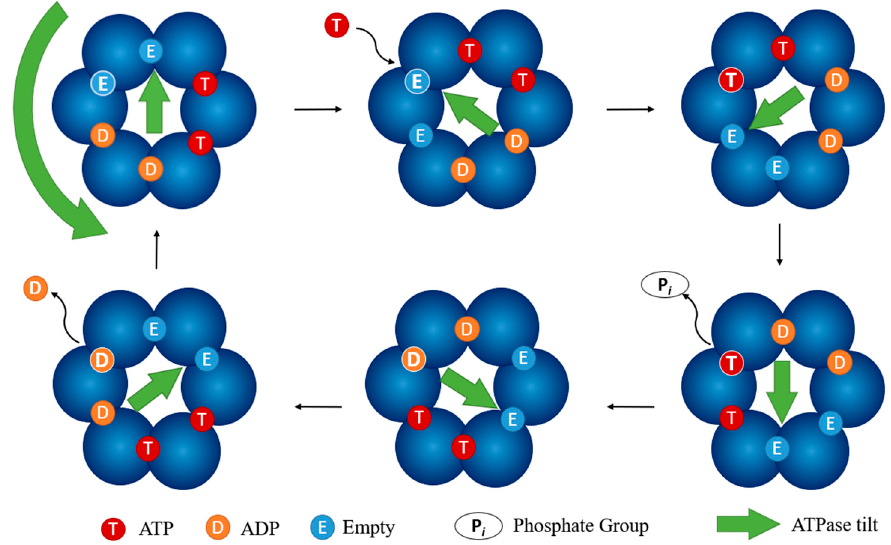
Figure 14. ATPase hexamer cycle of dephosphorylation. The tilt of the hexamer causes unfolded proteins to be “screwed” upwards through the channel and into the needle. Modified from [186].